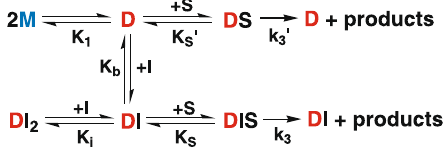
Fig. 8 Mechanism of activation and inhibition of MPro M by GC376. M, D, S, I, DS, DI, DI 2 , DIS denote monomer, dimer, substrate, inhibitor, dimer- substrate complex, dimer-inhibitor complex, dimer bound to 2 inhibitors, dimer bound to 1 inhibitor and 1 substrate, respectively.